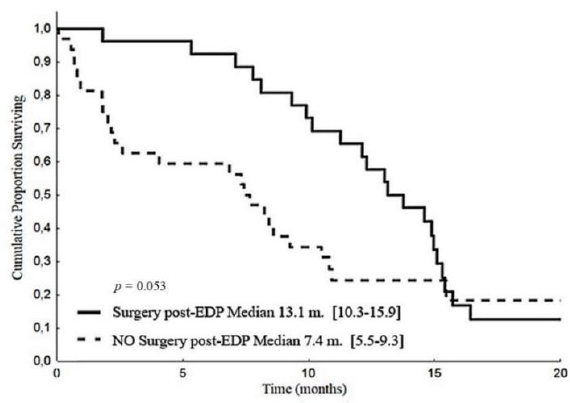
Figure 4. Progression-free survival according to post-EDP surgery.